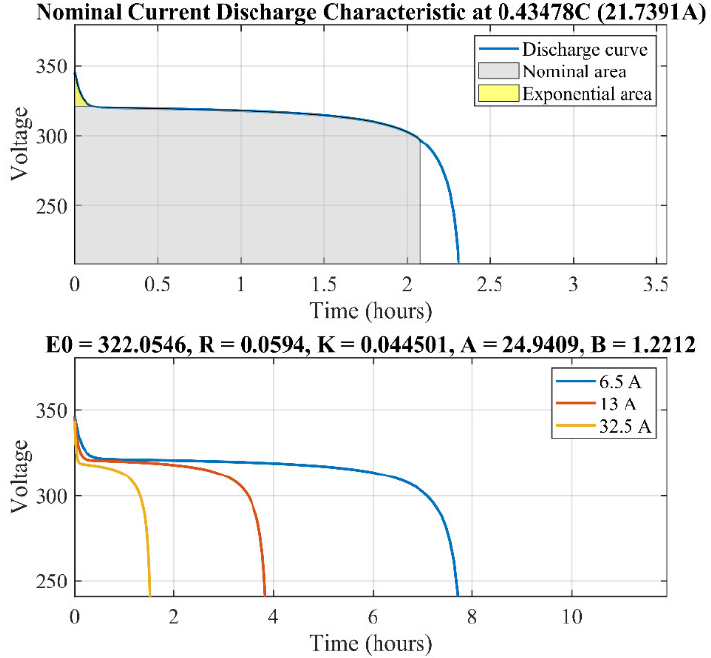
Figure 14. Relevant Li-ion current discharge characteristics.